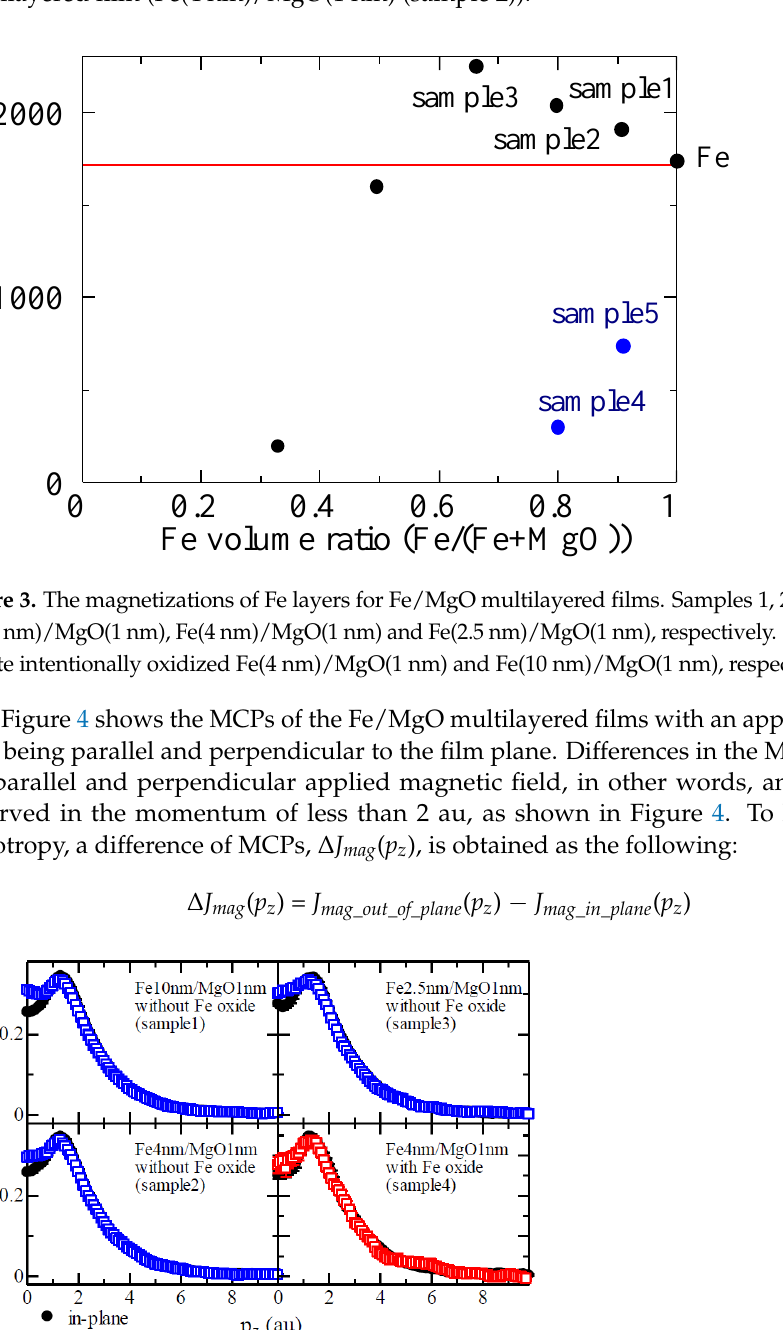
Figure 2. Images by transmission electron microscope (JEM-4000EX, JEOL) for ( a ) Fe(4 nm)/MgO(1